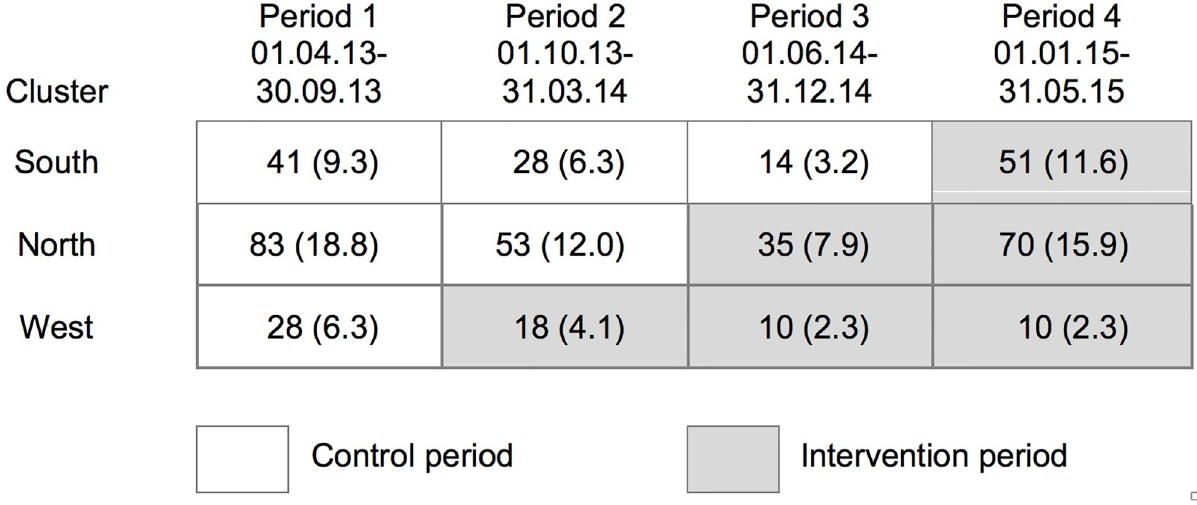
Fig 3. Patients recruited, and data collected in each cluster period n